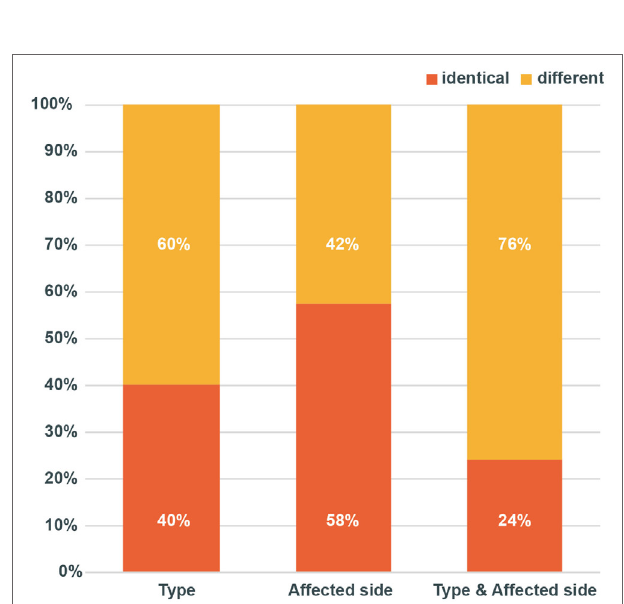
FigUre 4 | Patterns of recurrences. During the recurrences, proportion of the involved canals ( p = 0.9738) and affected side ( p = 0.7966) did not differ from those of the initial event (Chi-square test). Only 24% of the patients showed the recurrence in the same canal on the same side.